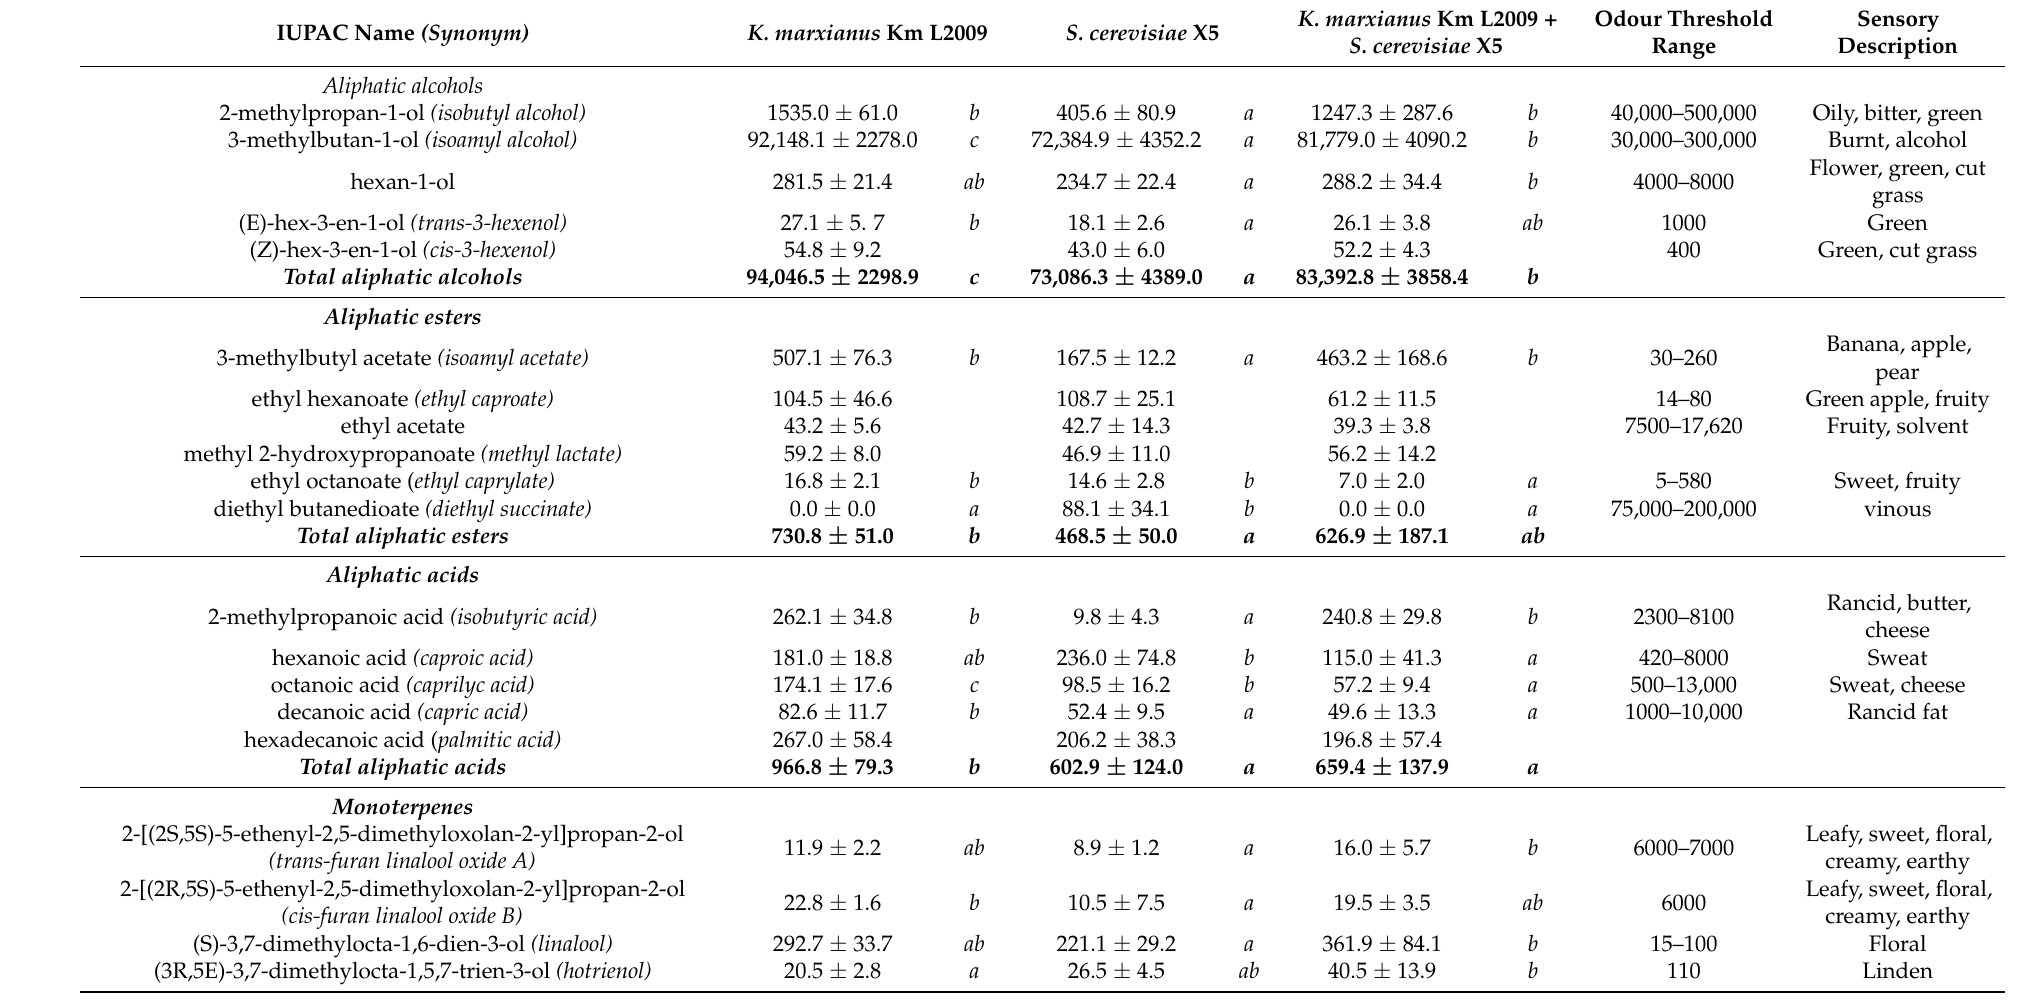
Table 3. Free volatile compounds (in µ g/L) found in lab-scale fermentations. Odor thresholds and sensory descriptions according to